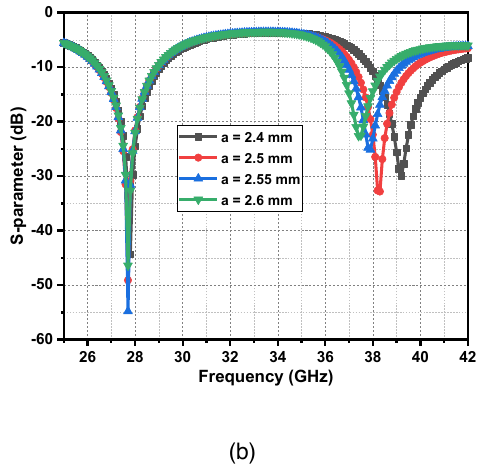
(b) FIGURE 3. S-parameters comparison of HFSS and ADS circuit models: (a) reflection and (b) transmission coefficients.